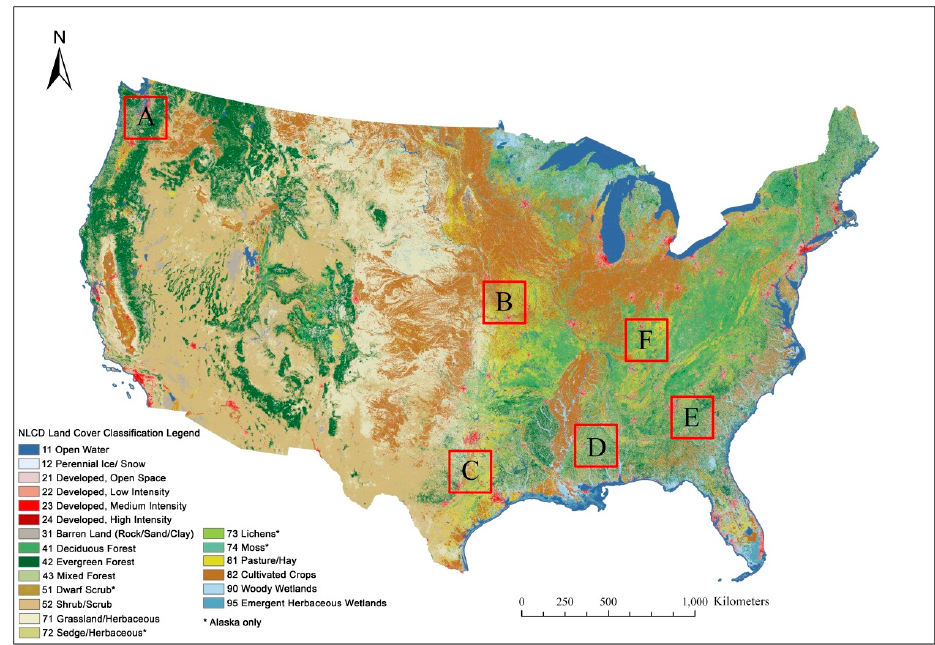
Figure 2. Locations of the six study areas as shown in the National Land Cover Database (NLCD) 2011 land cover map.